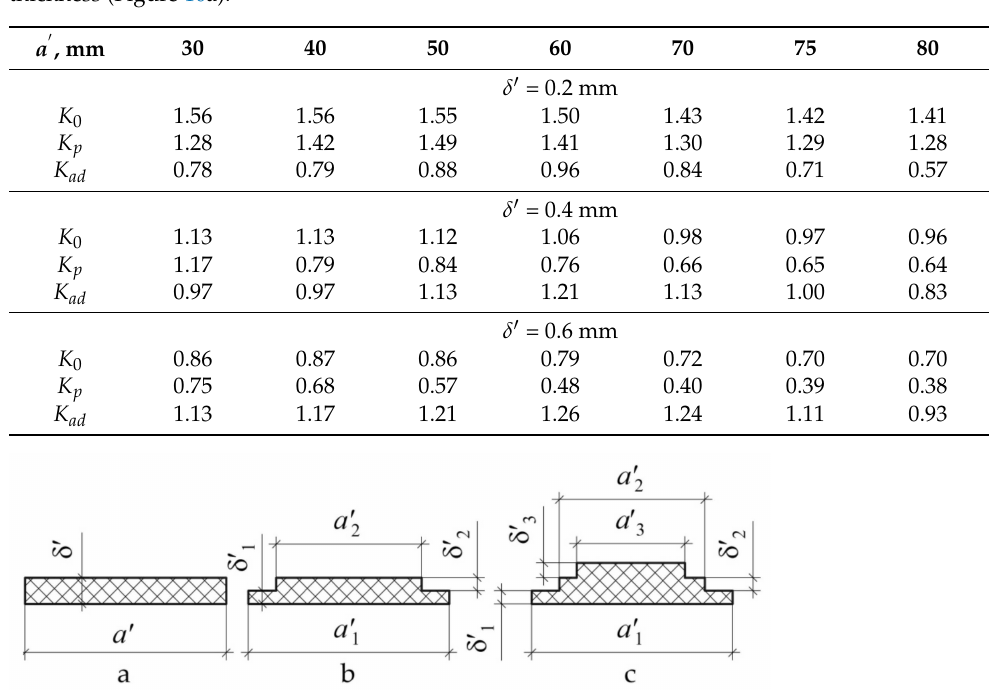
Table 1. Results of calculation of the loading factors with the use of the repair patch of uniform thickness (Figure 10a).